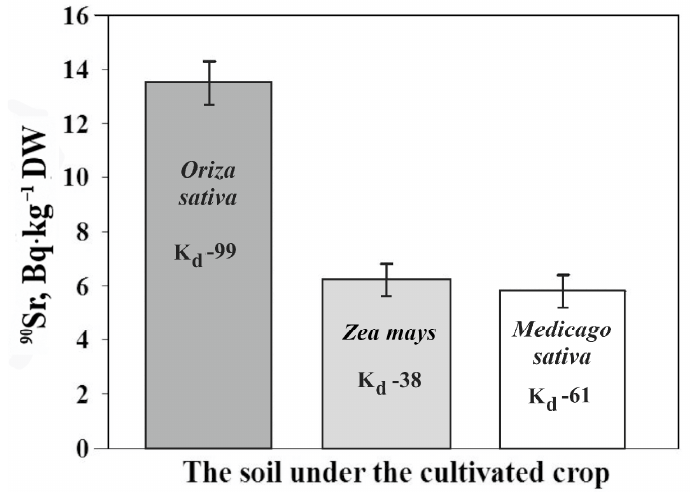
Figure 6. Average concentrations and distribution coefficients (K d ) of 90 Sr in irrigated soils under rice, corn, and alfalfa (1992–1995).